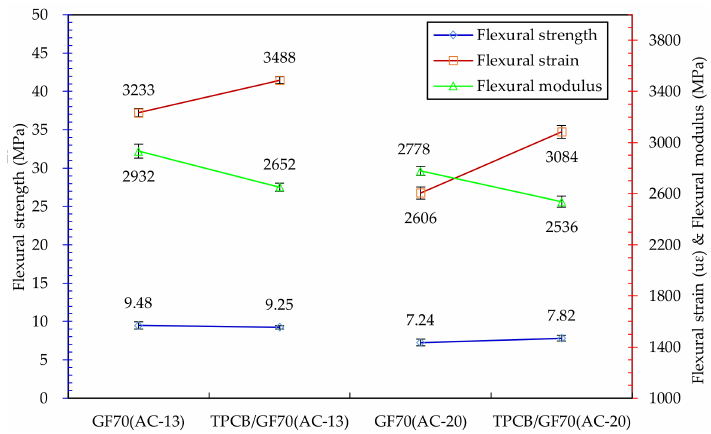
Figure 9. Results of low-temperature bending test of GF70 and TPCB/GF70 asphalt